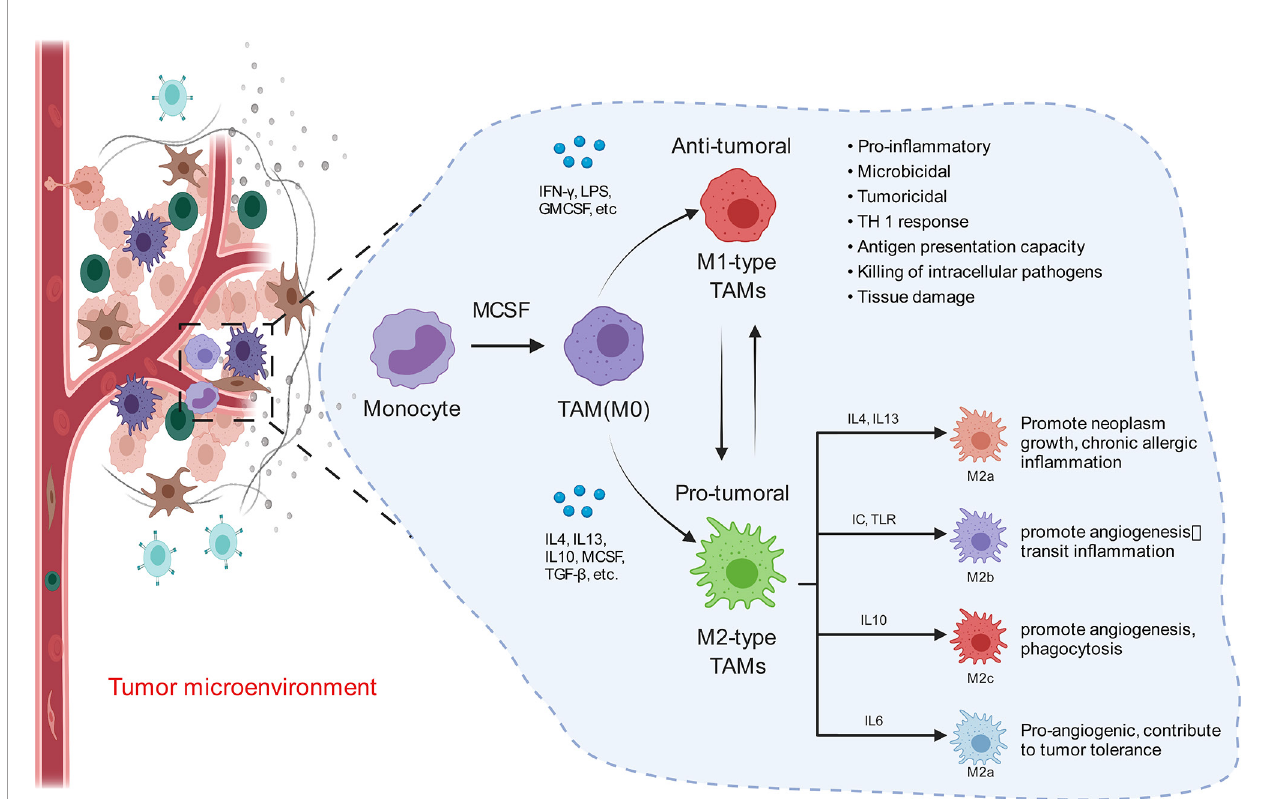
FIGURE 2 | Macrophages in the tumor microenvironment become tumor-associated macrophages (M0) once exposed to tumor substances (MCSF), and M0 can differentiate into M1 and M2. When activated by interferon - g and lipopolysaccharides, M1 macrophages show bactericidal activity and express high levels of CD86, inducible nitric oxide synthase, and pro-in fl ammatory cytokines, such as interleukin (IL-6), IL-12, IL-23, and tumor necrosis factor. M2 macrophages are activated by Th2 cytokines IL-4 and IL-13 as well as various parasite-related signals, which can be divided into four subtypes (M2a, M2b, M2c, and M2d). They are mainly involved in inhibiting type I in fl ammation and promoting tissue repair and healing